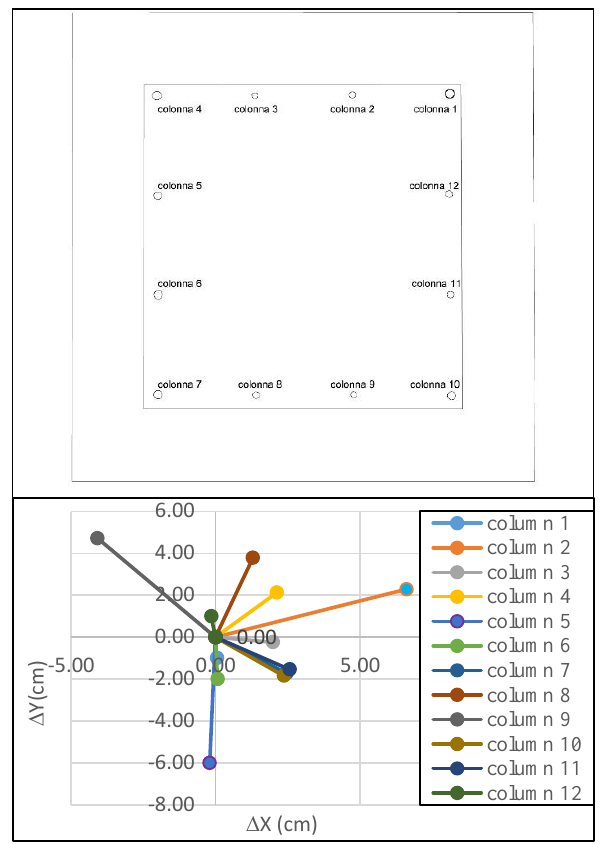
Figure 12. Representation of the first floor plan and vectors An extruded model from the gotten section from the bottom of every column has been produced and for every column a displacements map has been produced comparing the surveyed model and the extruded one. This kind of representation is useful to evaluate probable not linear displacement along all the altitude of the columns Figure 13.